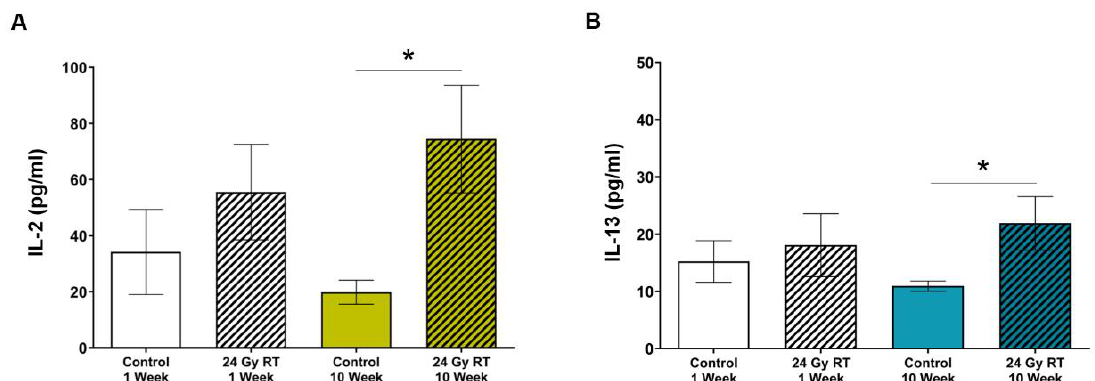
Figure 1. Salt-Sensitive (SS) wild-type (WT) rats have increased concentrations of circulating interleukin 2 (IL-2) and IL-13 after localized cardiac radiation. Adult SS WT female rats were administered either 24 Gy of localized cardiac radiation in one fraction or sham radiation. ( A ) A statistically significant increased concentration of IL-2 was detected in plasma 10 weeks post-radiation therapy (RT) compared to sham-treated. ( B ) Statistically significant increases in IL-13 were detected in plasma at 10 weeks post-RT compared to plasma from age-matched sham-treated rats. Plasma was collected at the time of harvest at one or 10 weeks post-RT ( n = 7–10/group, * p < 0.05).